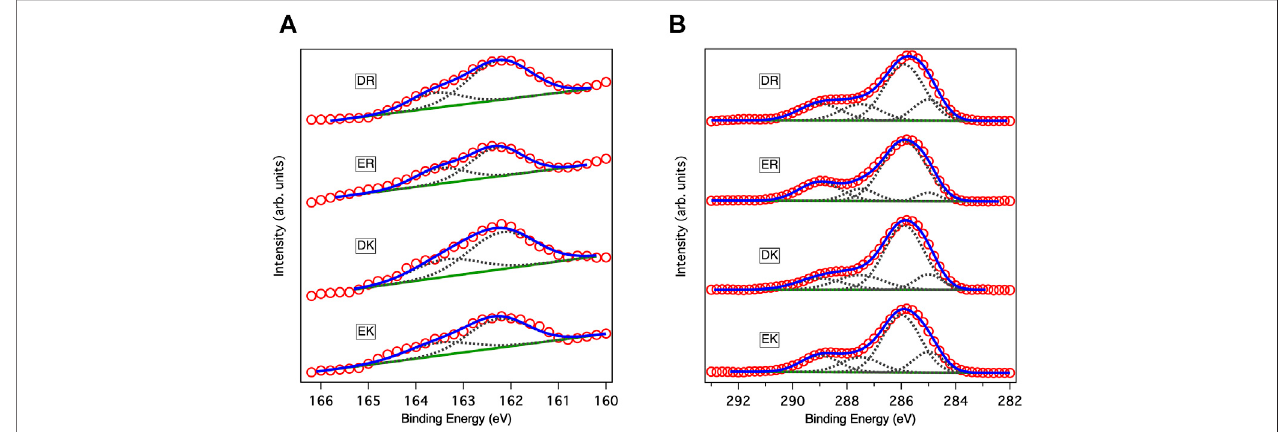
FIGURE1| XPspectraofpeptide-SAMsin (A) C1sand (B) S2pregions.Redcircles,solidbluelines,solidgreenlines,andgraydottedlinesshowdatapointsinthe spectra, fi tting results, backgrounds, and deconvoluted spectra, respectively. In fi tting the spectra in the S2p region, the ratio between the two states and the splitting gap were kept at 2:1 and 1.2 eV,